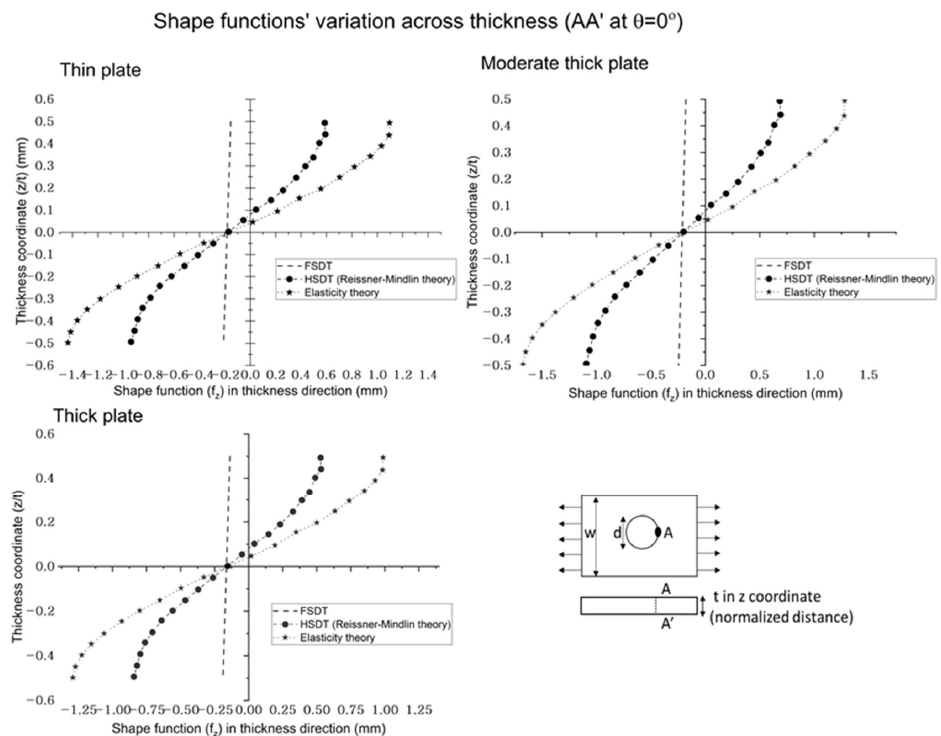
Figure 8. Transverse shear stress ( ꞇ rz ) variation with respect to uniaxial tension load.